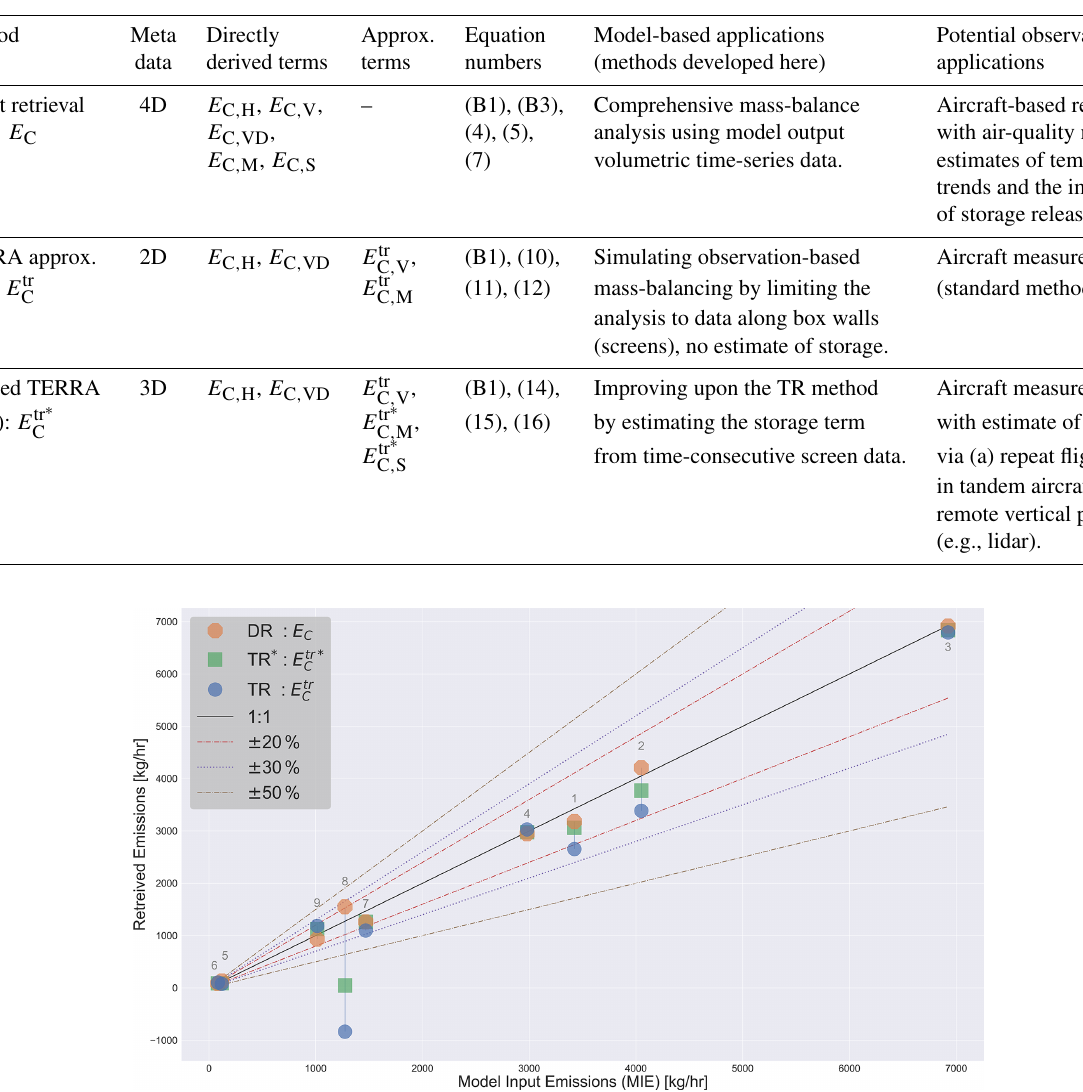
Table 1. Summary of the three retrieval methods: direct retrieval (DR), TERRA retrieval (TR) approximation and revised TERRA re- trieval (TR ∗ ). See Eqs. (4)–(15) and equations in Appendix B for descriptions of each term.